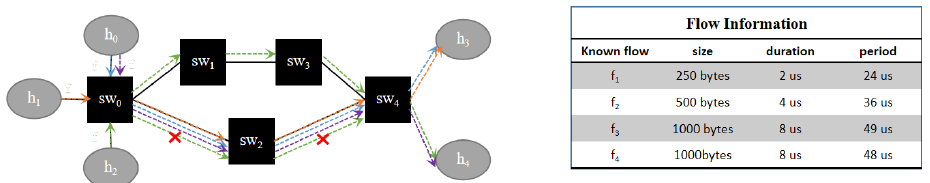
Figure 2. A scenario where four time-triggered flows traverse through one route [ sw 0 , sw 2 , and sw 4 ] generated by SRP routing algorithm.